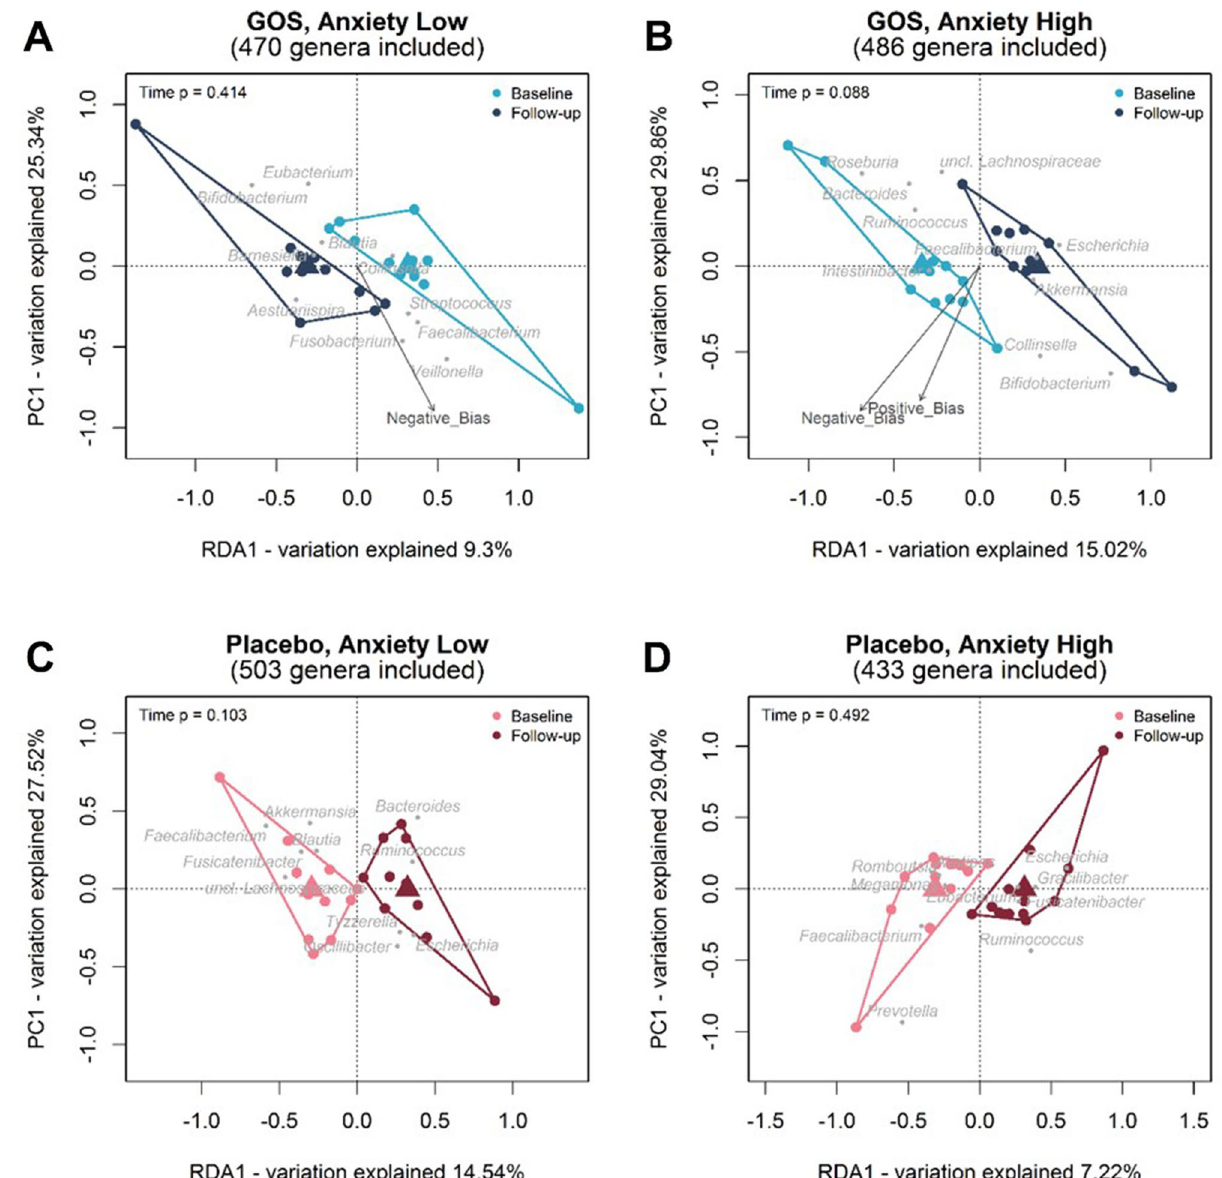
Figure 2. Ordination diagram from RDA for samples from the placebo and GOS group collected at baseline and follow-up, where the RDA indicates the association between Time [explanatory variables (x axis)] and bacterial community data on the Genus level. Scores of the first RDA-axis are plotted on the x-axis and scores of the first PCA-axis are plotted on the y-axis. Individual samples are represented by points that are coloured by time and samples belonging to the same collection time are enveloped. Triangles in the RDA diagrams represent the class centroids. Grey points and labels represent the 10 best-fitting genus level bacterial groups. The psychological measurements (environmental variables) are fitted onto the ordination and indicated by the named arrows. The arrow shows the direction of the (increasing) gradient, and the length of the arrow is proportional to the correlation between the variable and the ordination. Only those psychological measurements with a p value of < 0.10 are added to the ordination. The calculated p-value from Unrestricted Permutation Test is added to the upper left corner of the RDA